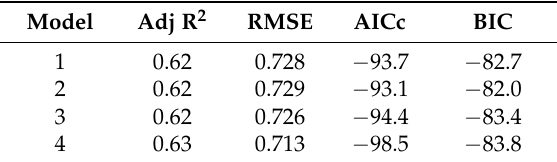
Table 4. Comparison models using cross validation goodness of fit criteria including the adjusted coefficient of determination (Adj R 2 ), root mean square of error (RMSE), the bias-corrected Akaike information criterion (AICc) and Bayesian information criterion (BIC).